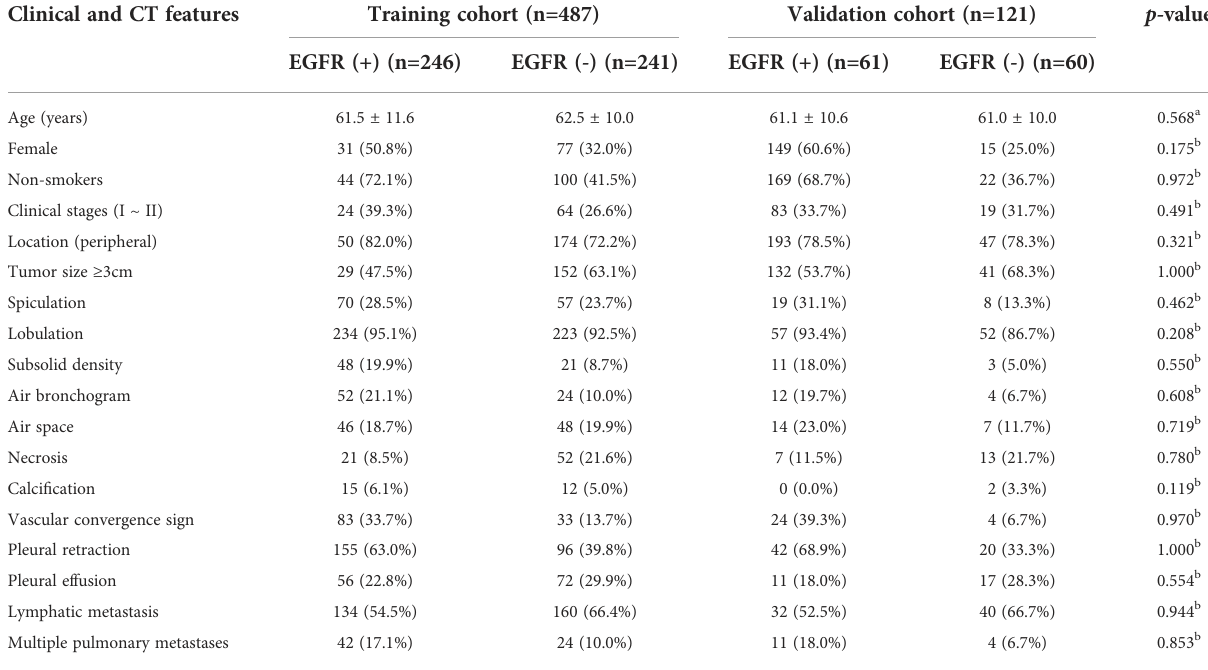
TABLE 2 Clinical and CT morphological features of patients with LADC in training and validation cohorts of model